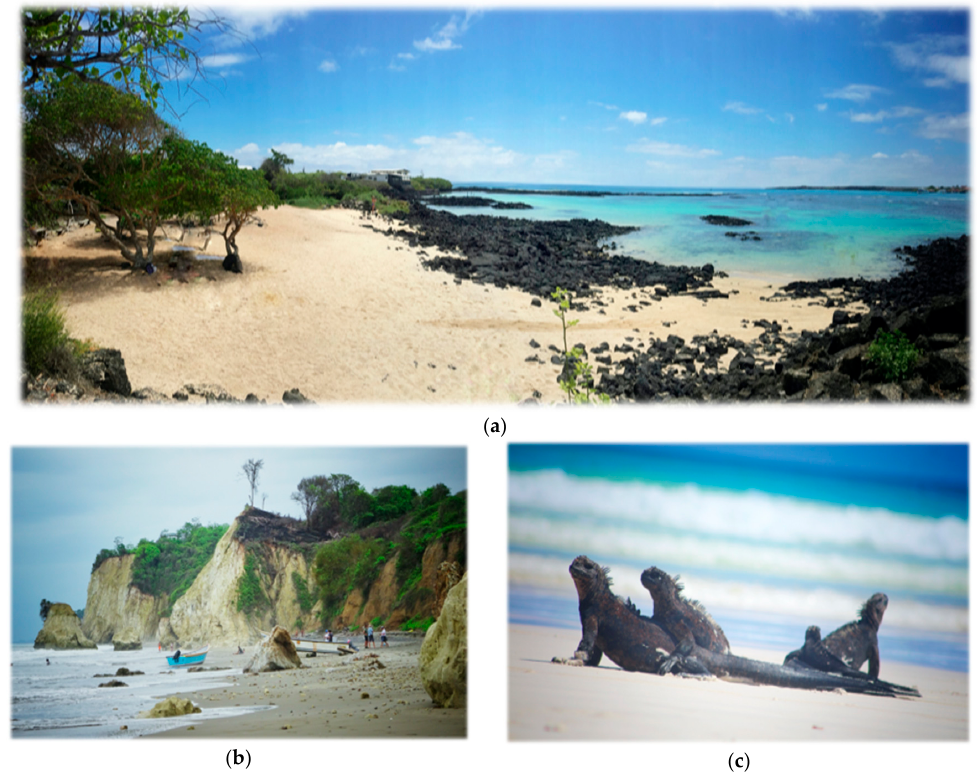
Figure 3. Public use of beaches: ( a ) Beach in the Galapagos Island; ( b ) Cliffs on the mainland; ( c ) Fauna on beaches, Galapagos Islands.